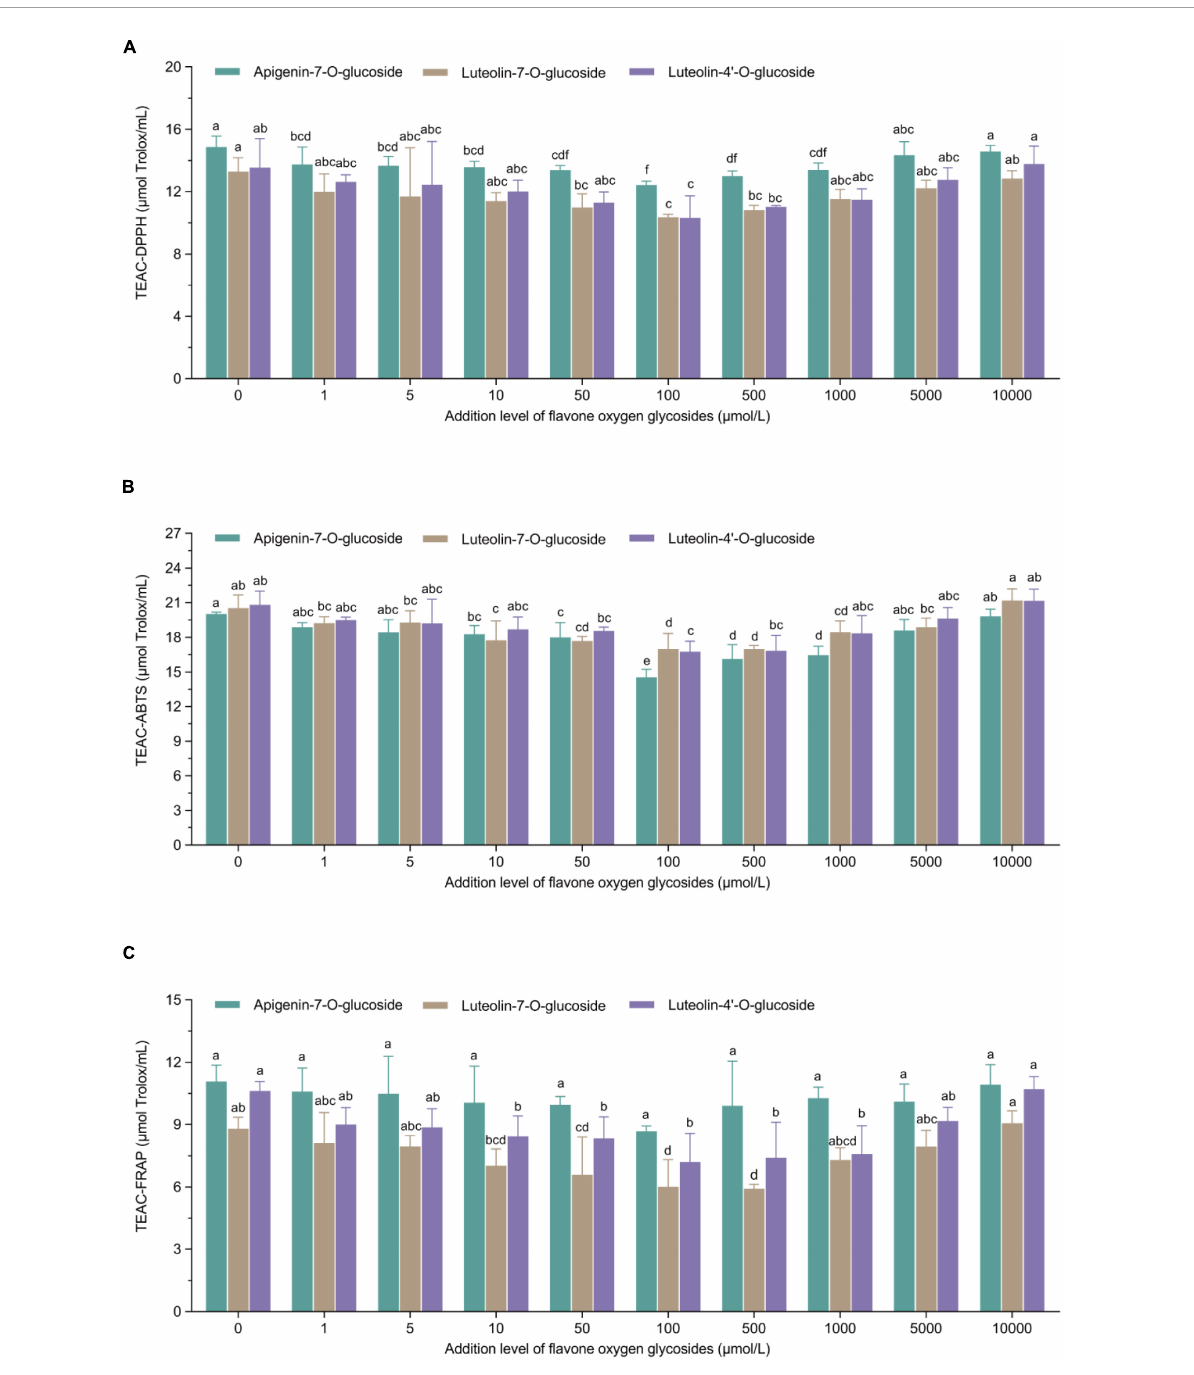
FIGURE3 U-shaped correlations between treatment levels of flavone oxygen glycosides and (A) TEAC-DPPH values, (B) TEAC-ABTS values, or (C) TEAC-FRAP values in Maillard reaction products. Data are shown as the mean ± SD ( n = 3). Values with different letters indicate significant differences between different additional levels at the same flavonoid ( P <